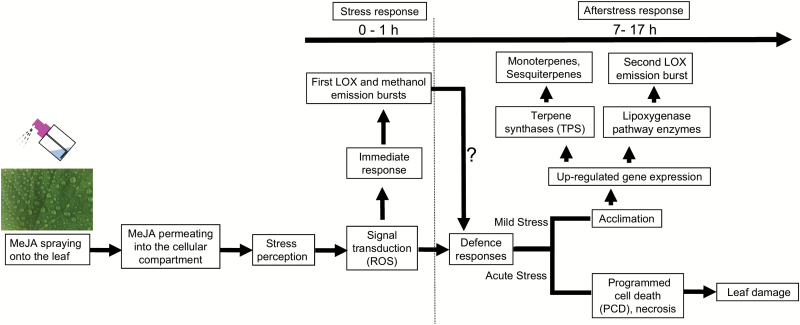
A conceptual model of elicitation of short- and long-term volatile responses upon MeJA treatment of cucumber leaves. Gaseous MeJA is taken up into the leaf internal air space through stomata, permeates further through cell walls and plasmalemma, reaching ultimately the symplastic leaf compartments. This activates an oxidative burst due to rapid formation of reactive oxygen species (ROS; Garrido et al., 2003; Zhang and Xing, 2008; Küpper et al., 2009; Hazra et al., 2017) and release of free polyunsaturated fatty acids from plant membranes (Dicke et al., 1999; Feussner and Wasternack, 2002; Andreou and Feussner, 2009) in several minutes after the treatment at the immediate location of MeJA impact. Due to the constitutive activity of lipoxygenases, free fatty acids are rapidly converted to volatile lipoxygenase pathway products (LOX products; Feussner and Wasternack, 2002; Andreou and Feussner, 2009), resulting in the first burst of LOX emissions (Fig. 2A). Simultaneously with the release of free fatty acids or maybe even somewhat earlier, constitutive pectin methylesterases (Micheli, 2001; Pelloux et al., 2007) are activated, resulting in major emissions of methanol (Fig. 2D). In a longer-term sequence of events probably involving endogenous jasmonate formation and interplay with jasmonate repressor proteins (JAZ) (Chini et al., 2007; Wasternack and Song, 2017; Zhang et al., 2017), plant defense responses depend on the initial stress severity. Mild and moderate stress caused by MeJA treatment (5, 10, and 20 mM) is expected to lead to elicitation of gene expression level defenses including enhanced expression of terpenoid synthase (TPS; Martin et al., 2002, 2003; Byun-McKay et al., 2006) and lipoxygenase pathway genes (Bell and Mullet, 1991; Wasternack and Parthier, 2007), resulting in volatile terpene and LOX emissions that are sustained for long time periods of ~20–30 h (Fig. 2B, C). In the case of moderate stress, propagation of necrotic lesions remains localized (Fig. 1A). In contrast, acute MeJA stress (50 mM) leads to enhanced progression of programmed cell death (PCD), and subsequent rapid propagation of necrosis over the entire leaf surface (Fig. 1A).